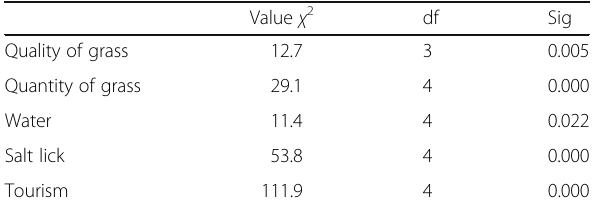
Table 6 Chi-squared tests for significant difference between how